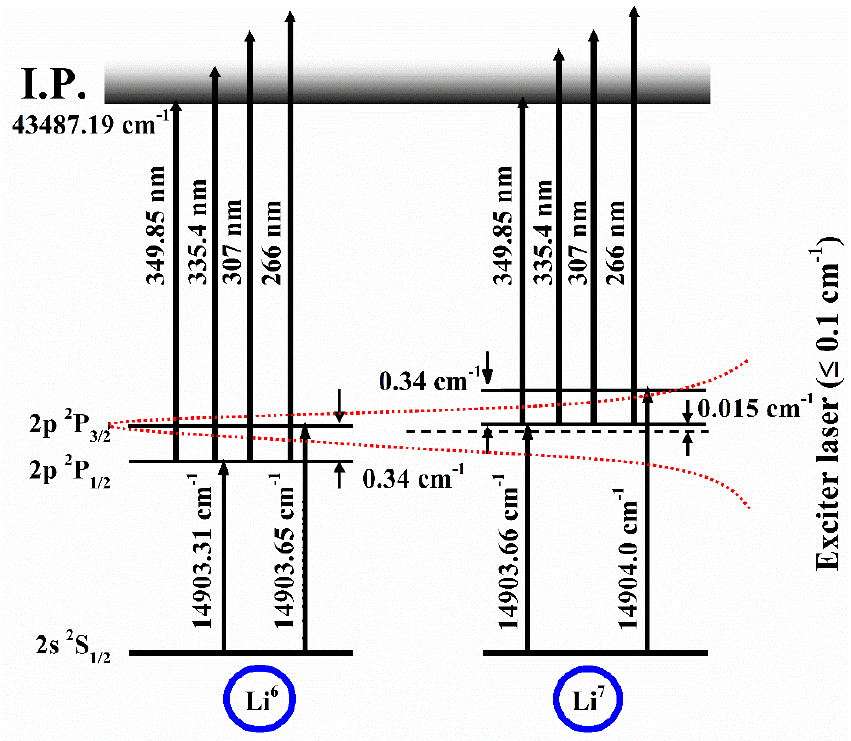
Figure 2. The schematic diagram for two-step photoionization of lithium isotopes.